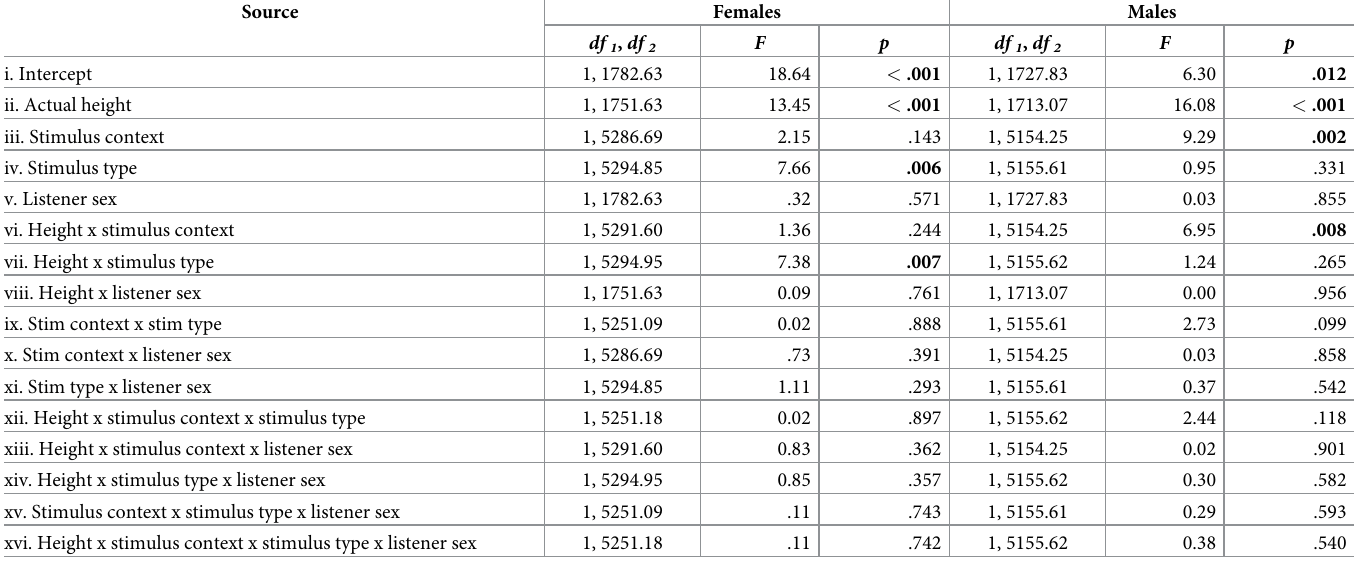
Table 6. Height estimation: Linear mixed models testing the effects of actual height, stimulus context, stimulus type, and listener sex on the rated height of females and males.